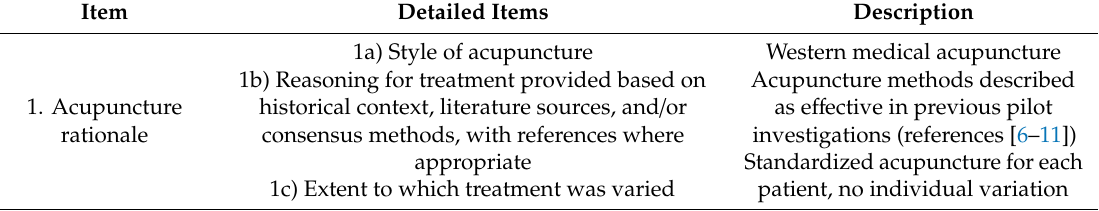
Table 1. Interventions details by Standards for Reporting Interventions in Clinical Trials of Acupuncture (STRICTA)